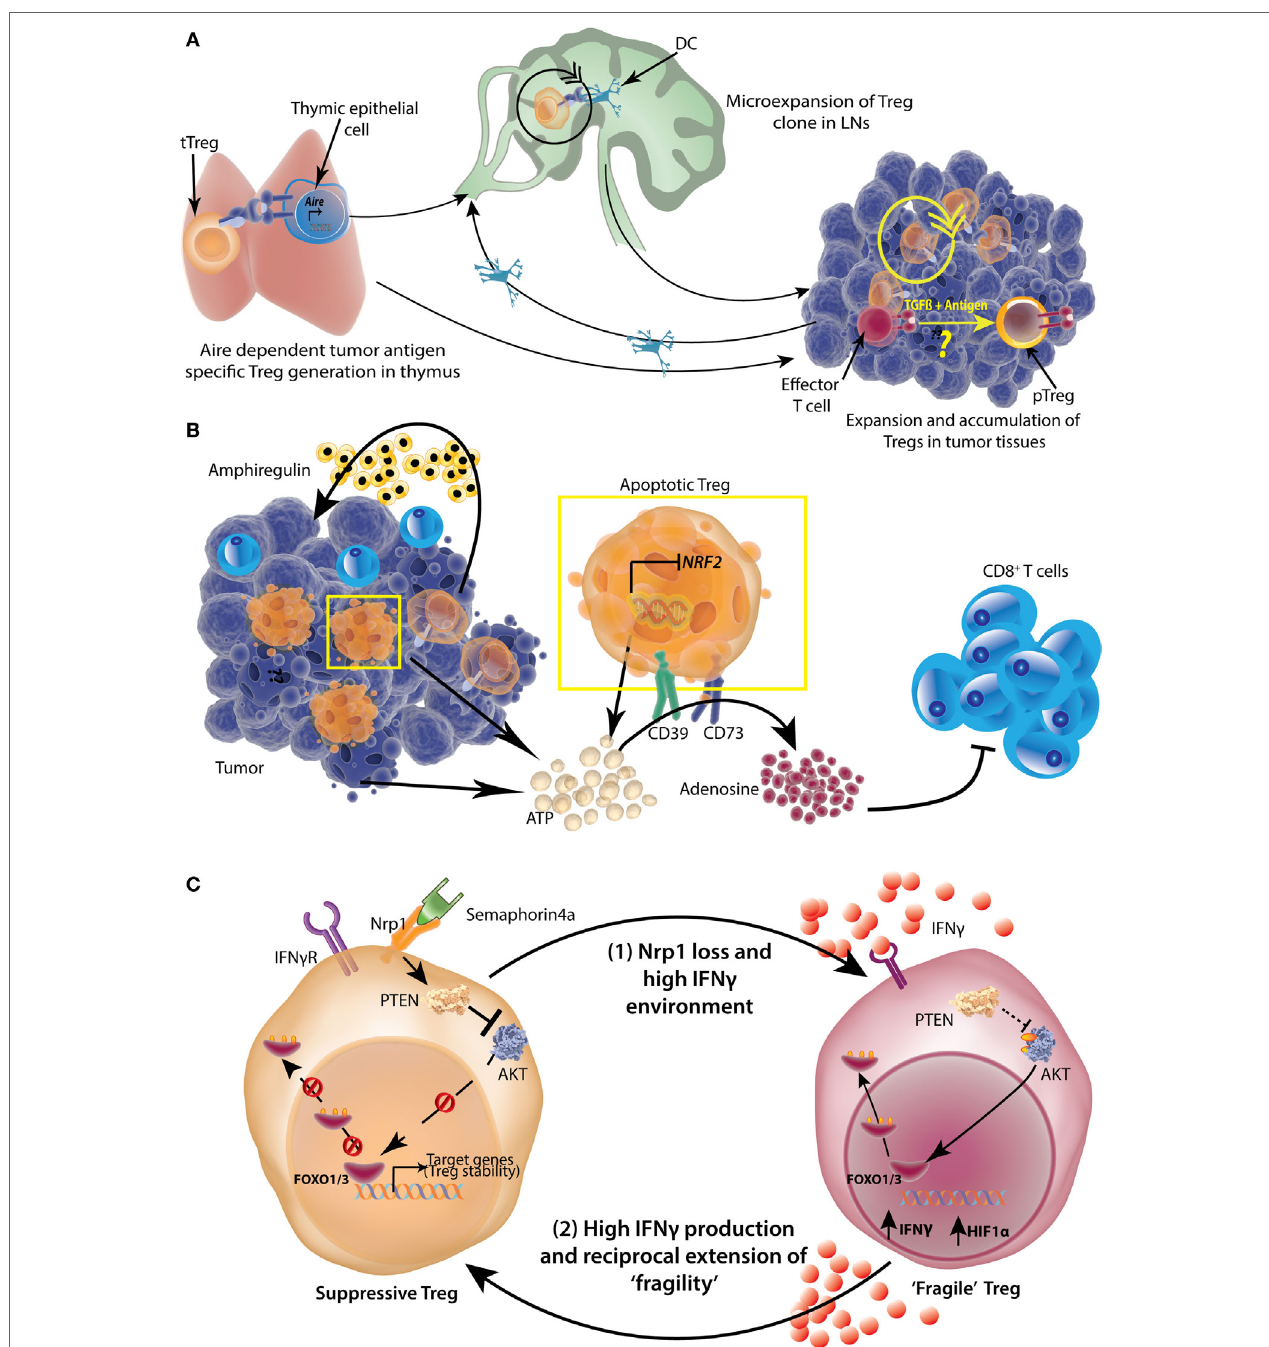
FiGURe 7 | Origin, accumulation, and functional potentiation of tumor-infiltrating regulatory T-cells (Tregs). (A) Tumor-specific antigens can be expressed by thymic epithelial cells in an Aire -dependent manner, which then select the tumor antigen-specific Tregs. These Tregs then expand in tumor draining lymph nodes (LNs) with the help of dendritic cells (DCs). Tregs can also be directly recruited to tumors and undergo expansion there. While intratumoral conversion of effector T-cells to pTregs is likely, the extent to which this occurs under physiological conditions is not completely understood. (B) A high number of TI-Tregs are apoptotic because of suppressed expression of Nrf2 . These Tregs as well as dying tumor cells release copious amounts of ATP, which is converted to adenosine by Treg ectoenzymes CD39 and CD73 in a sequential manner. The resulting adenosine is highly suppressive to tumor-infiltrating CD8 + effector T-cells. Further, Tregs also produce Amphiregulin in certain tumor types, which help in tumor progression. (C) More than 50% of TI-Tregs express surface Neuropilin1 (Nrp1), which is a receptor for Semaphorin 4a. Upon ligation with Semaphorin4a, Nrp1 activates lipid phosphatase Phosphatase and tensin homolog (PTEN) which promptly dephosphorylates AKT rendering its sequestration in cytosol and nuclear retention of Foxo1/3 transcription factors which help in stabilization and survival of Tregs. A loss of Nrp1 renders Treg highly susceptible to IFN γ and such Tregs also produce high amount of IFN γ and HIF1 α (“Fragile” Tregs). The resultant high IFN γ environment, reciprocally, can induce “fragility” in other Nrp1-sufficient Tregs as well, setting up a vicious cycle.